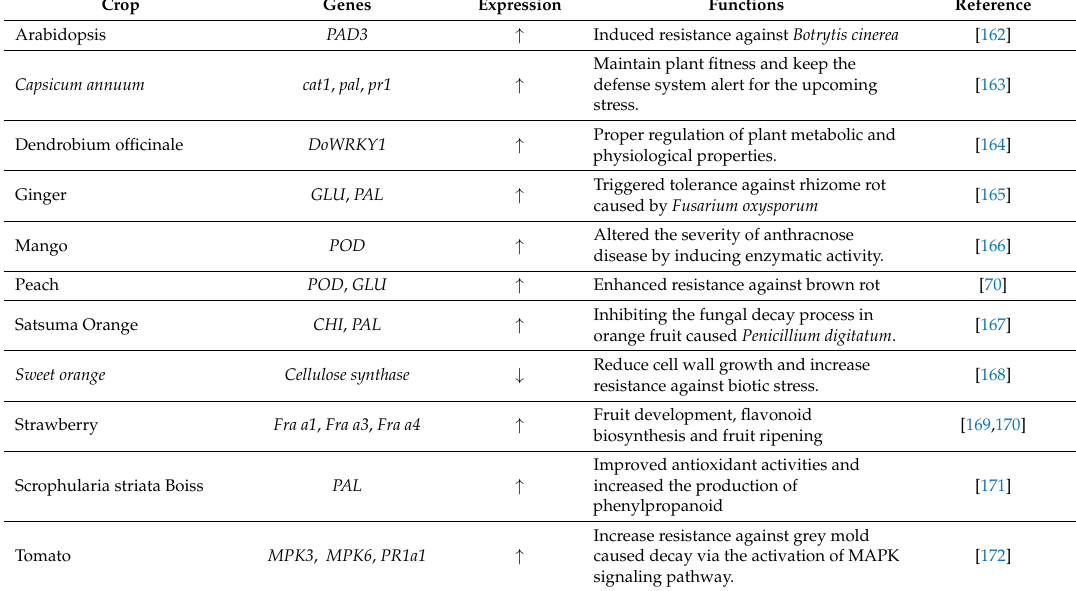
↑ showing up-regulation and ↓ down-regulation of the respective genes presented in the